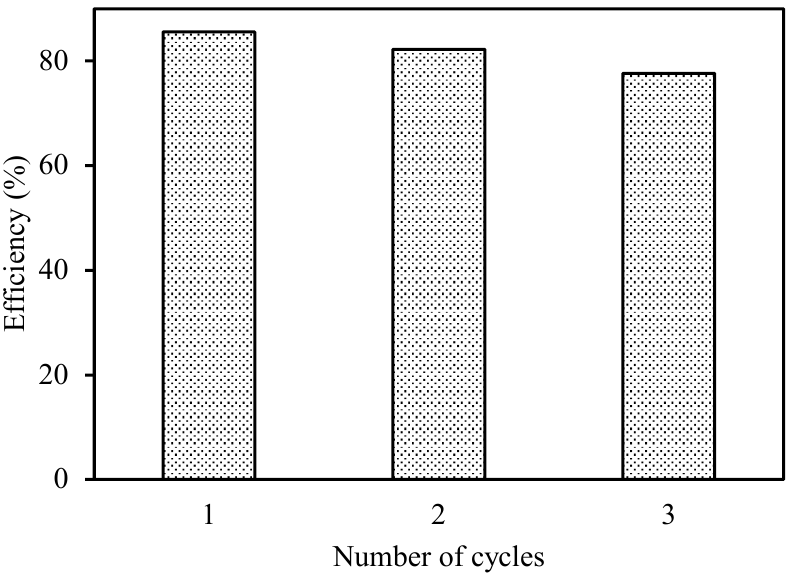
Figure 9. Reusable performance of ASB/N,S-TiO 2 composite.